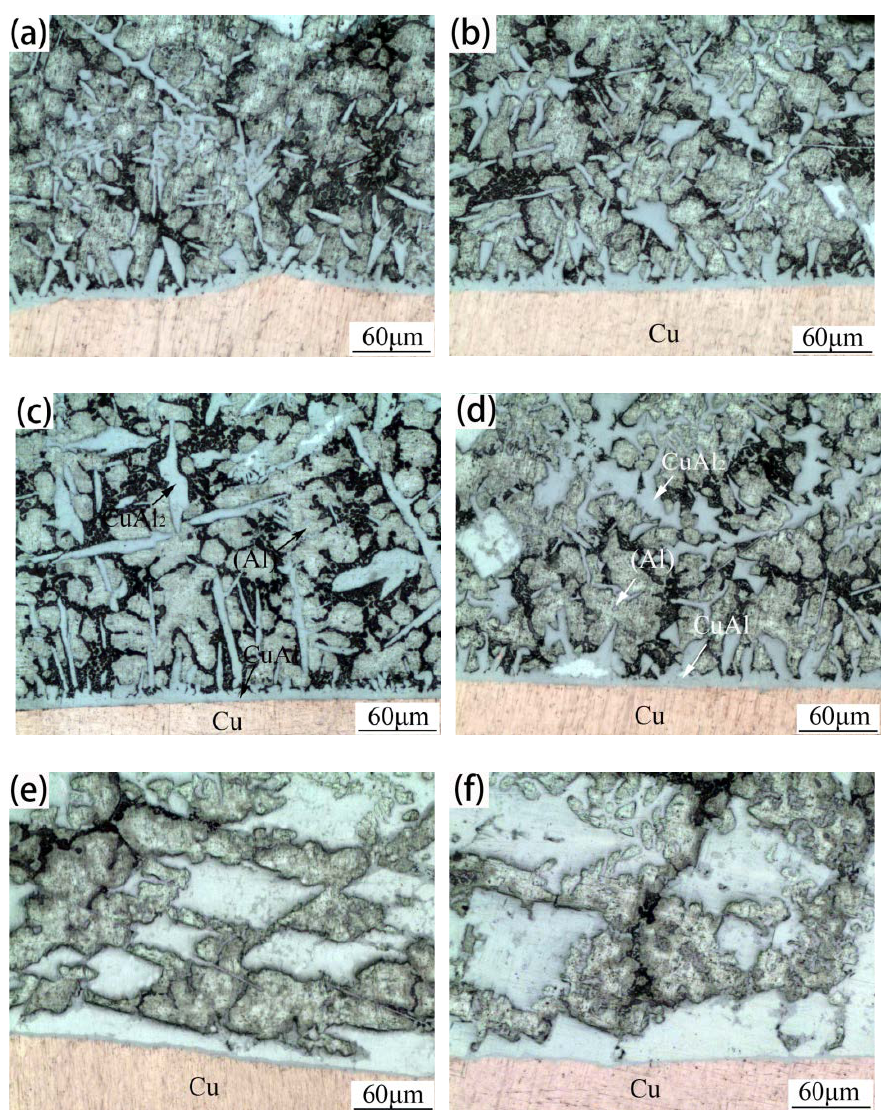
Figure 8. Microstructures of Cu/brazing seam interfaces of 3003 Al/Cu joints brazed by ( a ) Zn-2Al; ( b ) Zn-5Al; ( c ) Zn-12Al; ( d ) Zn-15Al; ( e ) Zn-20Al; and ( f ) Zn-25Al.